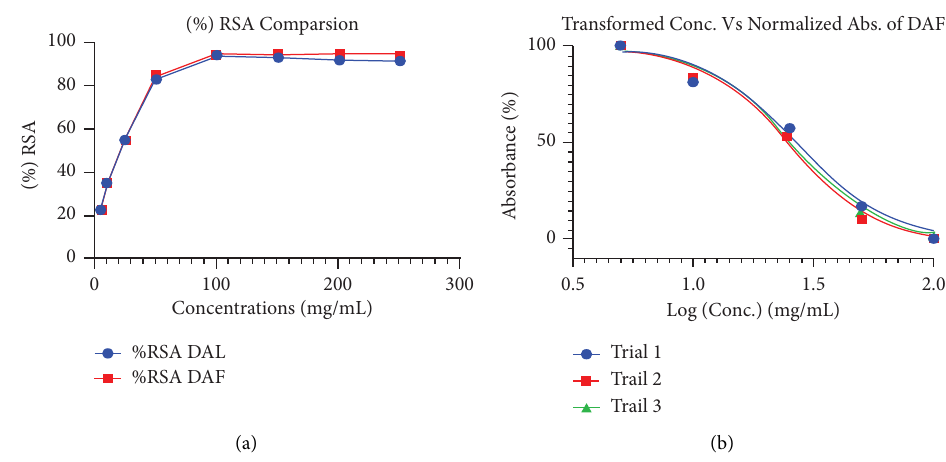
Figure 2 : (a) Graph comparisons for % RSA and (b) log (conc.) vs. normalized